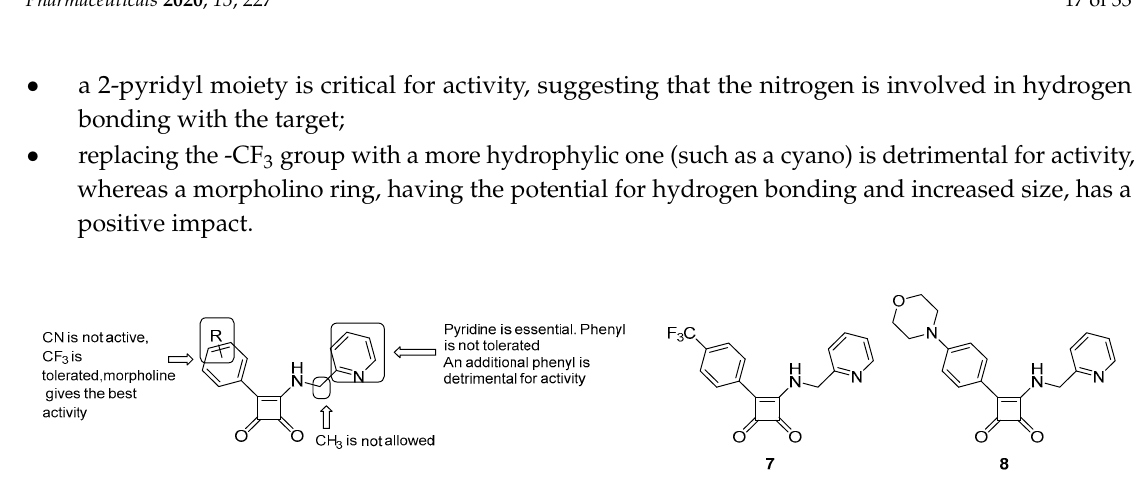
Figure 19. SAR analysis for the squaramide class and chemical structures of hit 7 and its improved analogue 8.